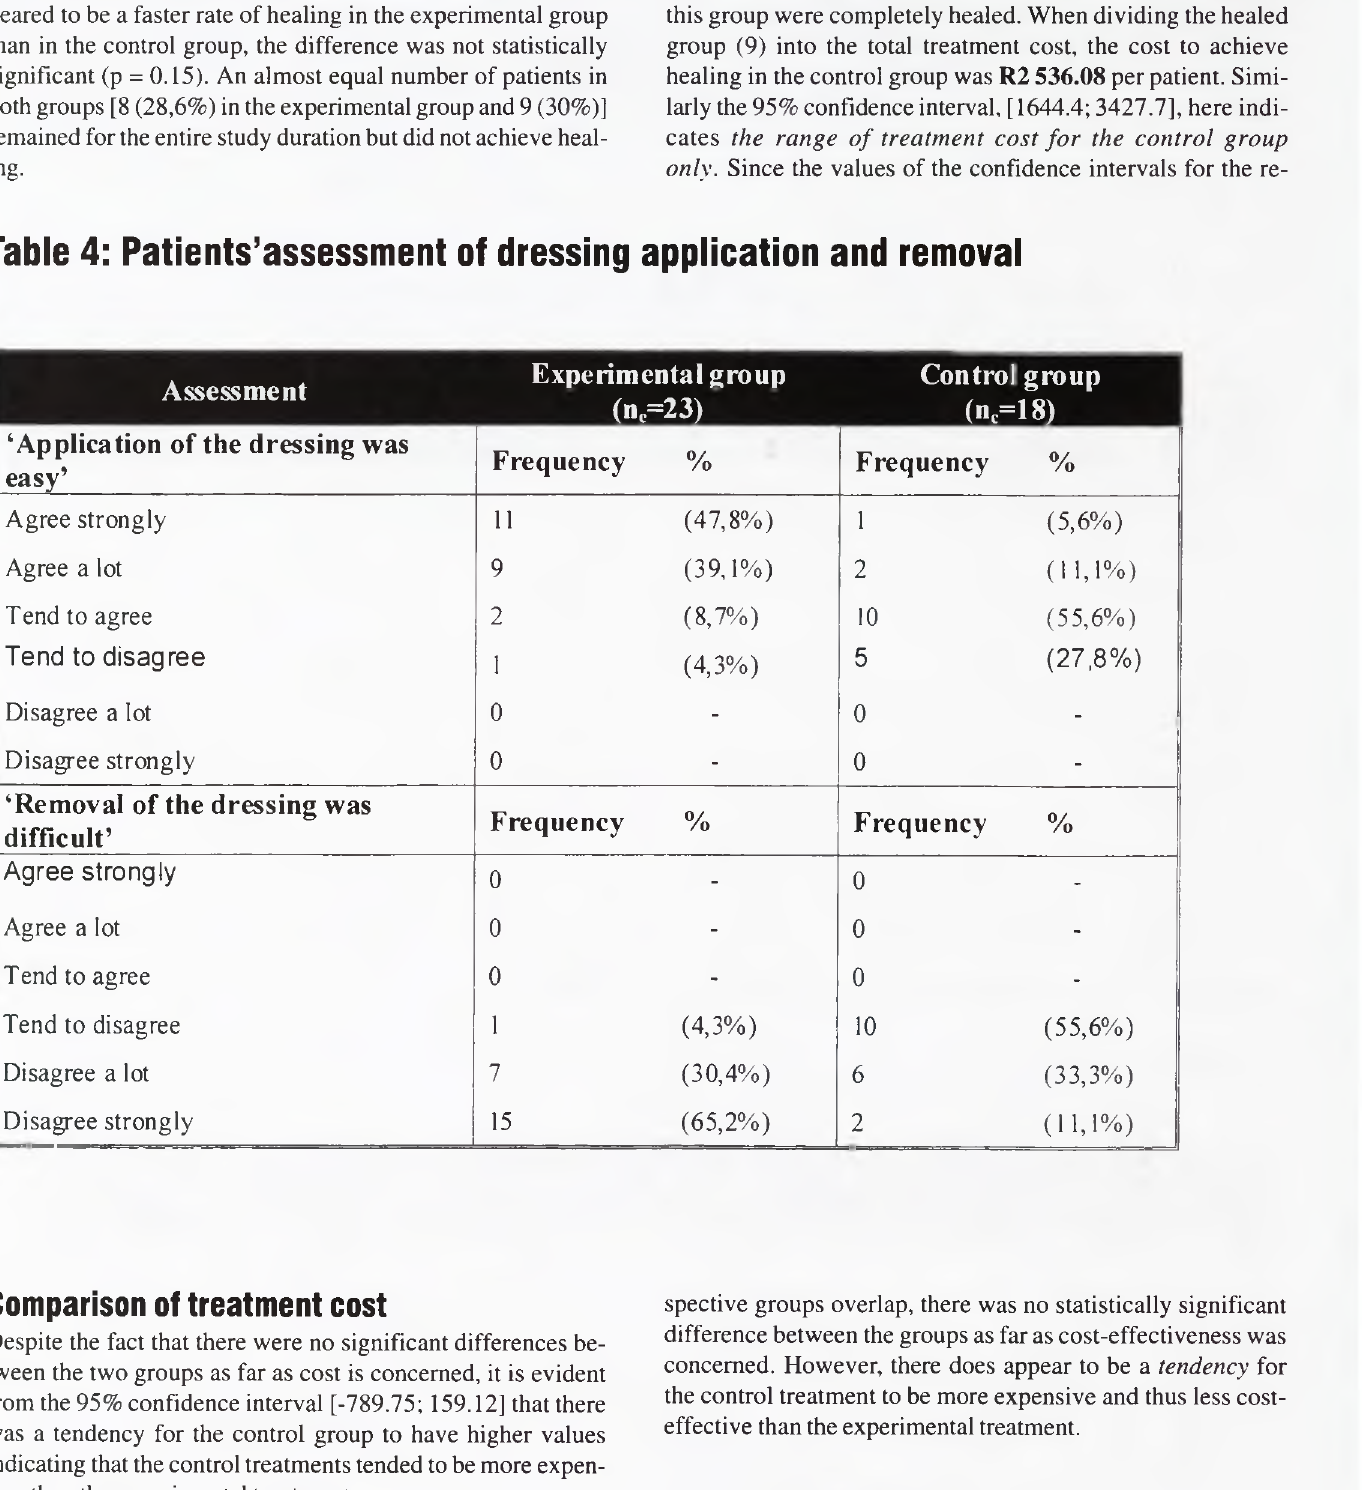
Table 4: Patients’assessment of dressing application and removal